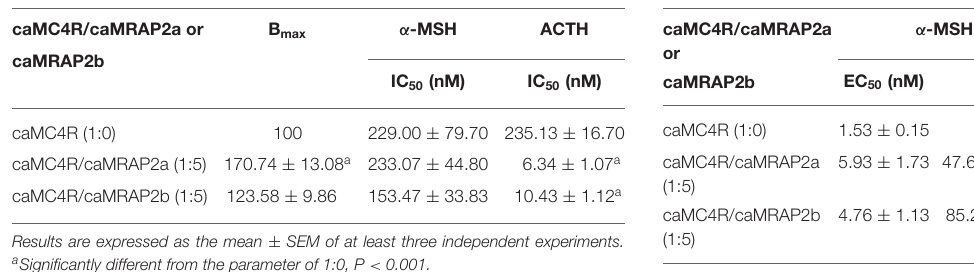
TABLE 3 | The effect of caMRAP2a or caMRAP2b on ligand binding properties of caMC4R.